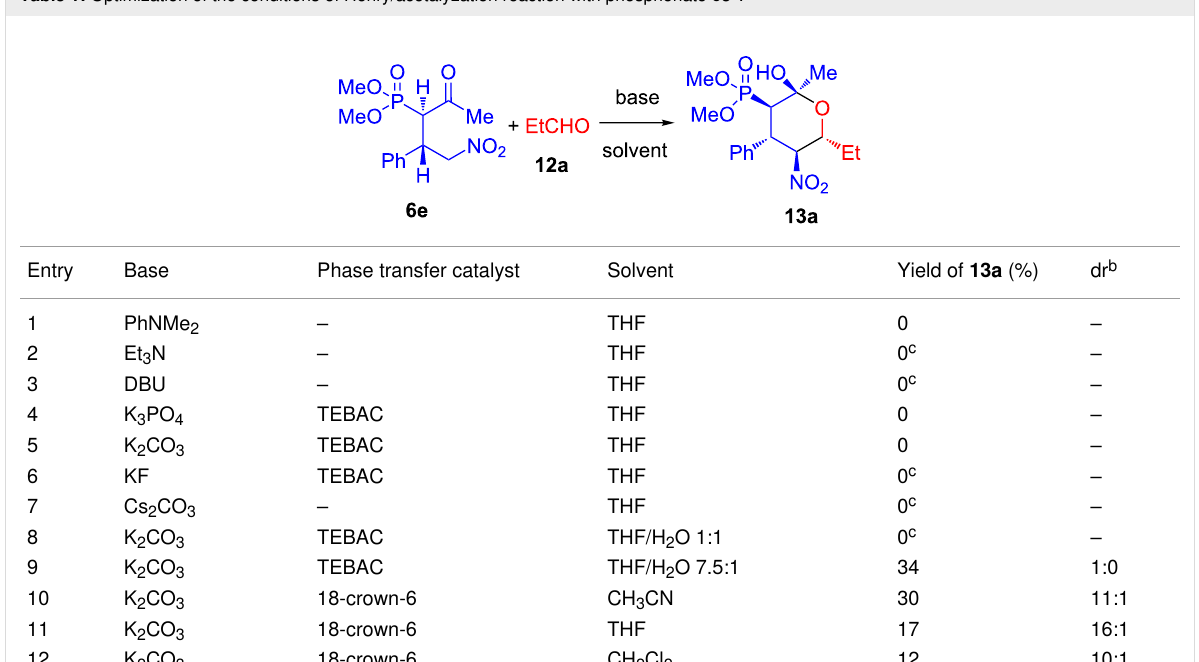
Table 1: Optimization of the conditions of Henry/acetalyzation reaction with phosphonate 6e a .